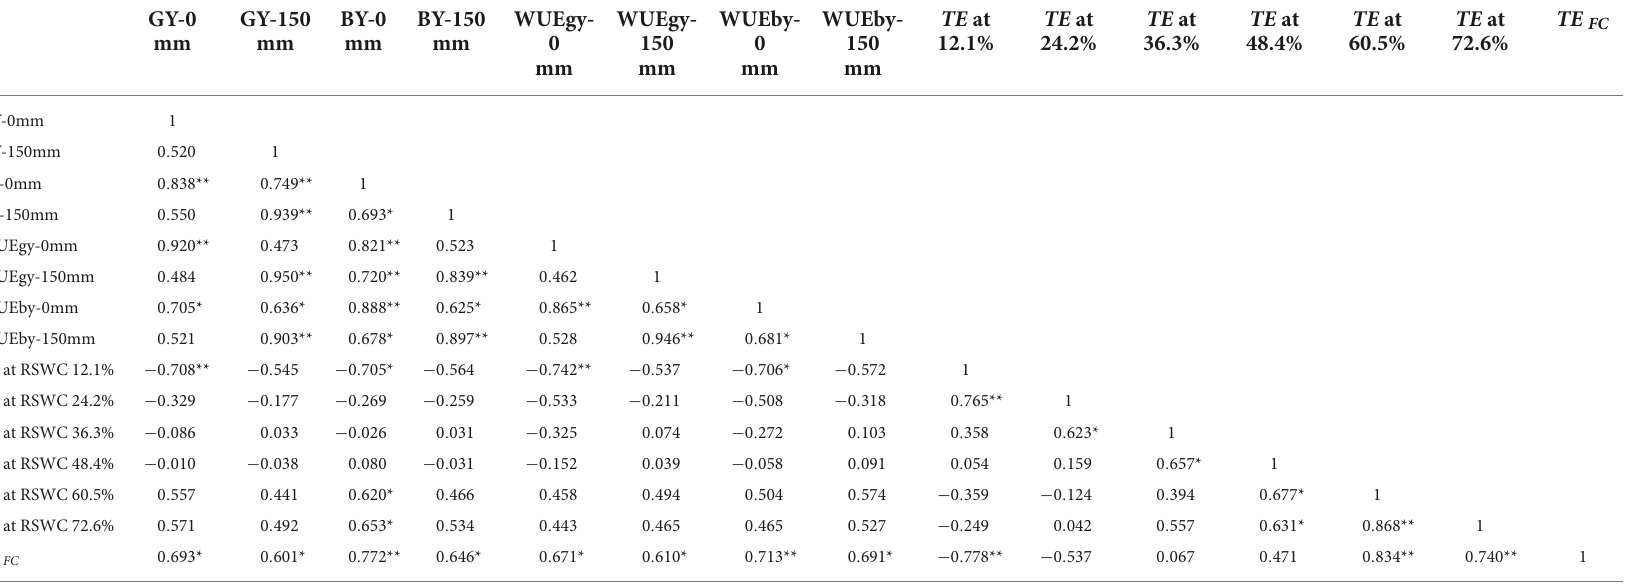
TABLE 2 Correlation analysis between field measured yield ( GY , grain yield; BY , biomass yield), water use efficiency ( WUE gy , WUE at grain yield level; WUE by , WUE at biomass yield level), pot measured transpiration efficiency ( TE ) at different SWC levels ( TE at x%, TE shoot measured at x% of SWC .) and TE FC ( TE measured at field capacity, the parameter of the power function TE = TE FC × ( RSWC ) b